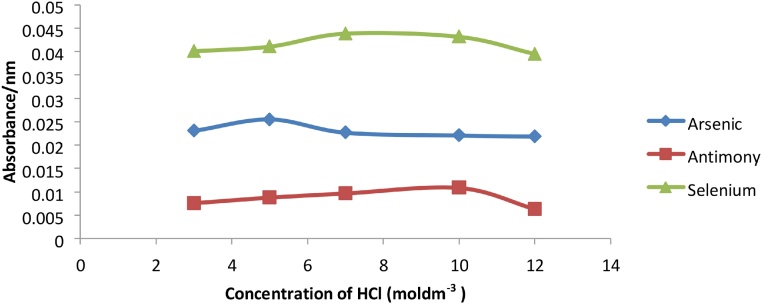
Graph of absorbance vs SnCl2 concentration for Hg.